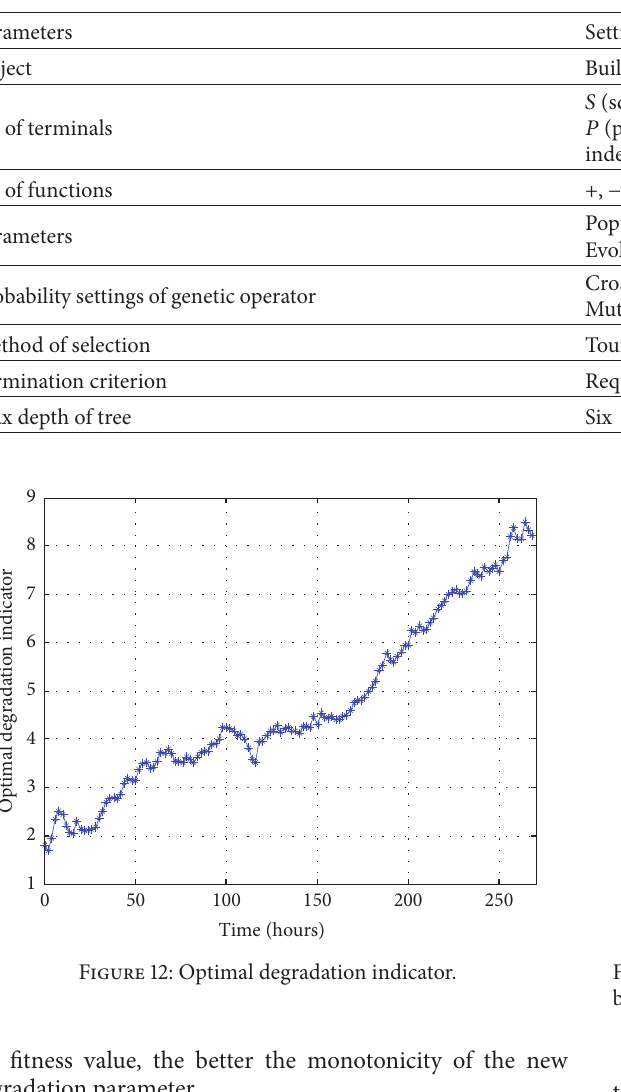
Table 2: Basic parameters of GP.